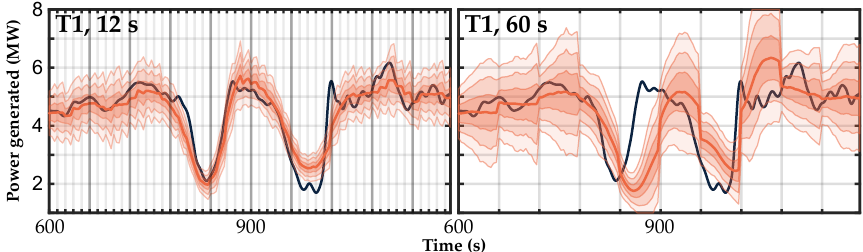
Figure 13. Comparison of the predicted power generated by Turbine 1 in an EnKF framework which is updated every 12 s to one which is updated every 60 s. The vertical lines indicate the frequency of